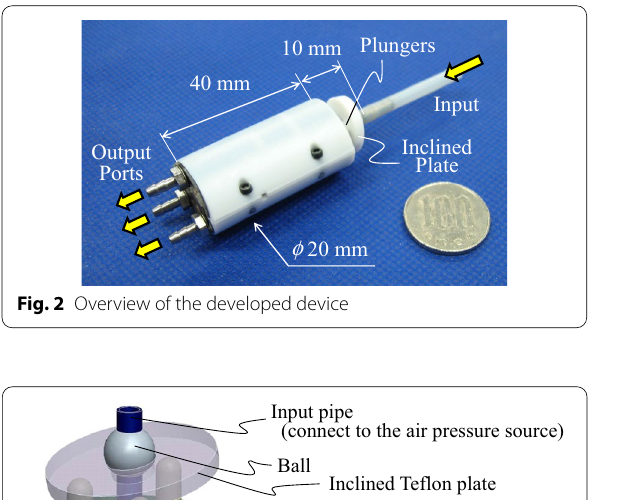
Extended plunger